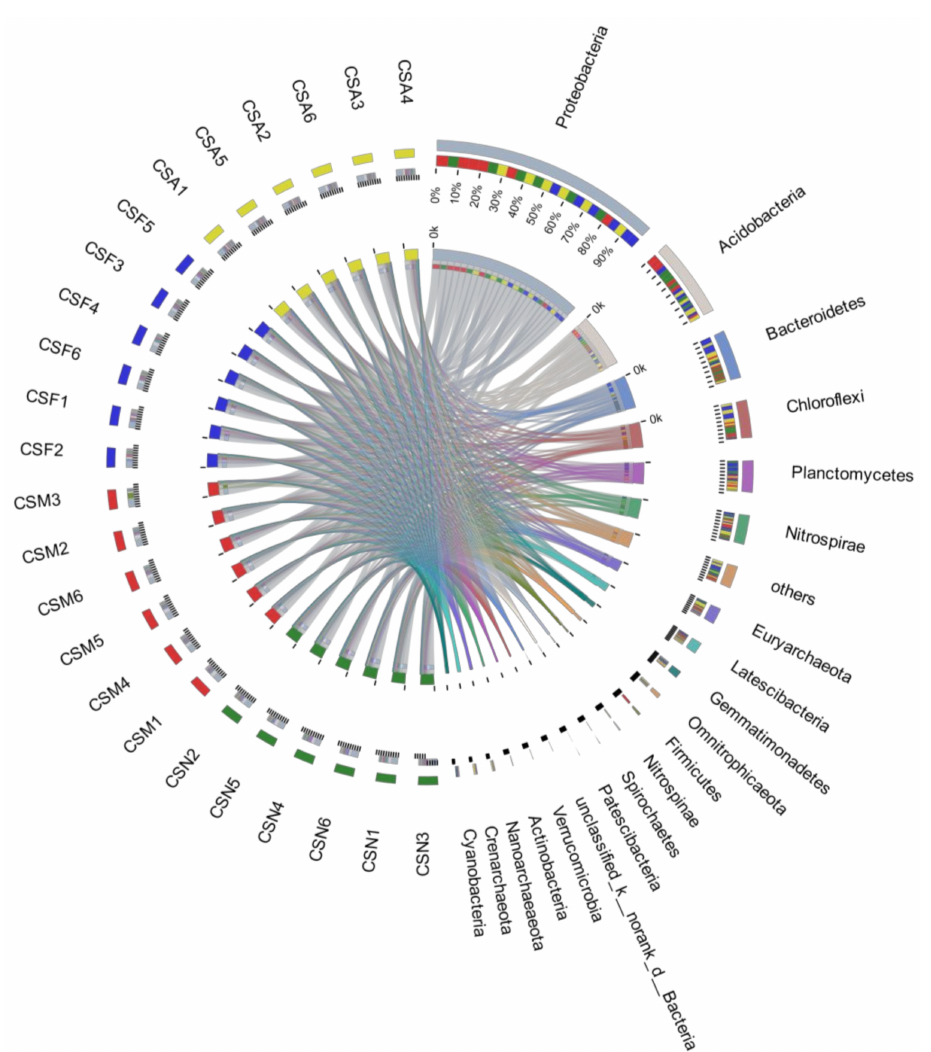
Figure 3. Distribution of the microbial community for each sample at the phylum level. Circos [51] visualized the data. The width of the bars for each phylum indicates the relative abundance of the phylum in the sample. CS indicates the sediments of Lake Chaohu, A (August), F (February), M (May) and N (November) indicate four months, and 1 to 6 indicate sampling points C1 to